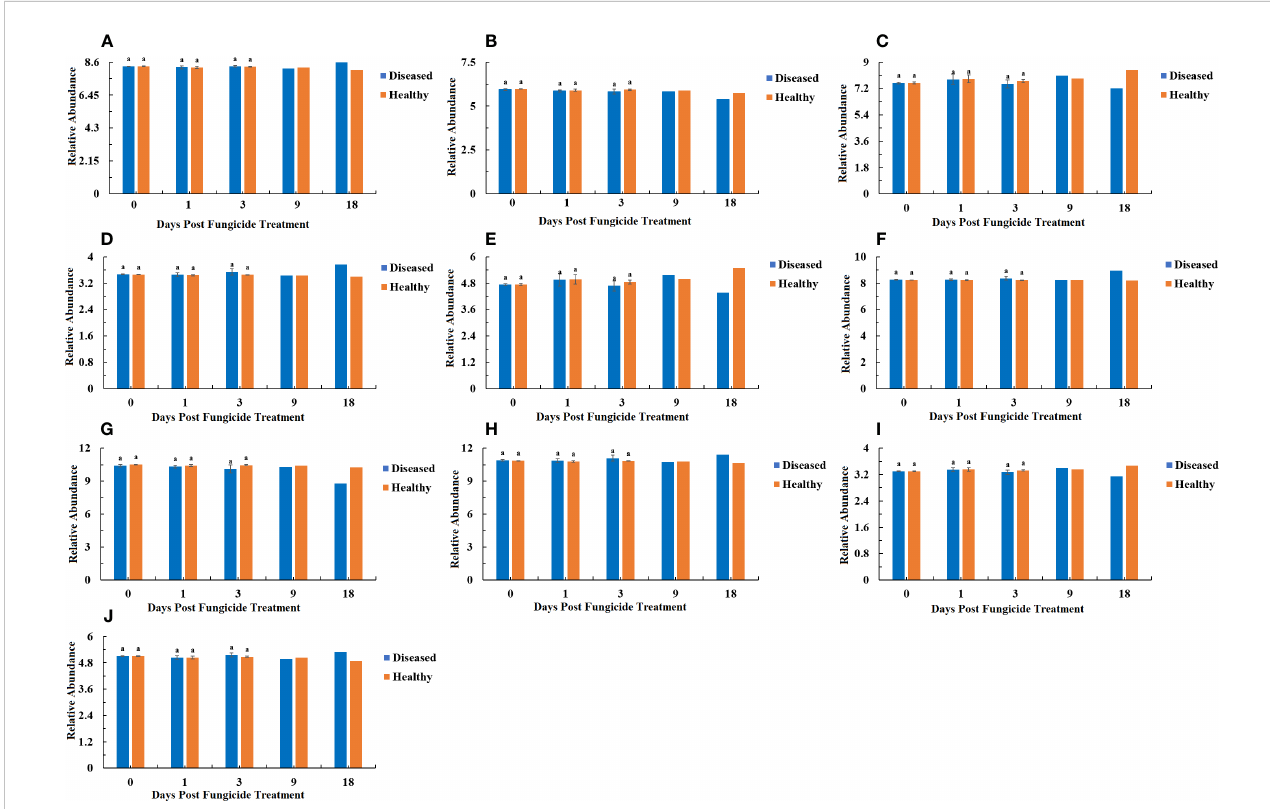
FIGURE 9 PICRUSt analyses of the changes in the KEGG level 2 functional categories of bacteria in tobacco leaf samples. (A) Carbohydrate Metabolism, (B) Metabolism of Cofactors and Vitamins, (C) Replication and Repair, (D) Cellular Processes and Signaling, (E) Translation, (F) Amino Acid Metabolism, (G) Energy Metabolism, (H) Membrane Transport, (I) Nucleotide Metabolism, (J) Poorly Characterized. Statistical analysis was not performed for results of diseased samples at 9 and 18 dpt as there was only one